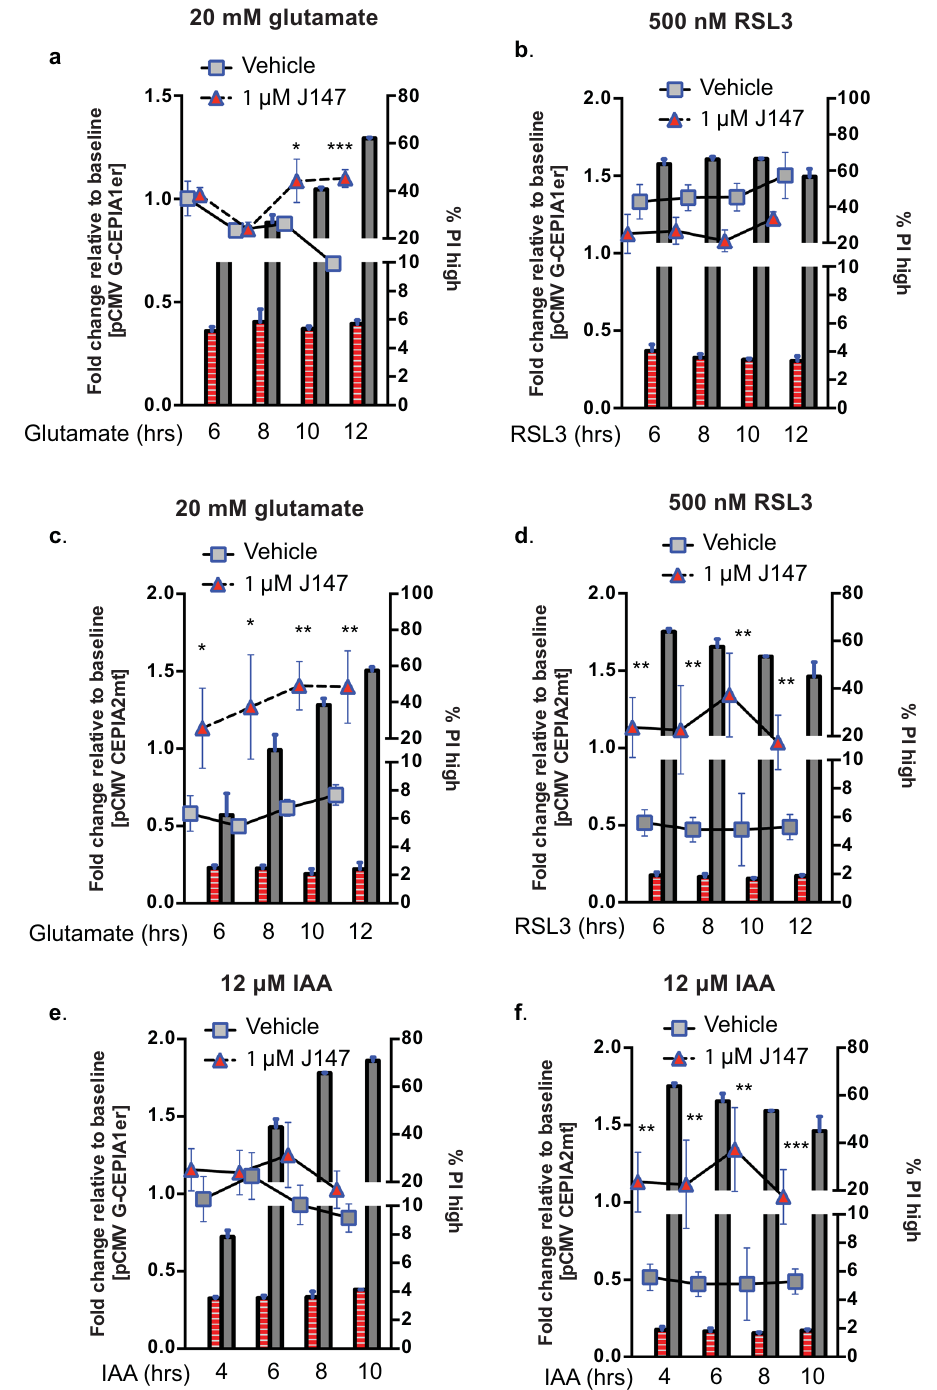
Fig. 5 J147 prevents/normalizes Ca 2 + fl uctuations during glutamate, RSL3, and IAA toxicity. Flow cytometry was used to assess Ca 2 + changes in propidium iodide (PI) positive HT22 cells transfected with genetically encoded Ca 2 + sensors targeted to the ER or mitochondria (red (J147) and gray (vehicle) symbols, dotted lines, left y -axis). Propidium iodide (PI) was used to separate cell populations corresponding to cell viability (red (J147) and gray (vehicle) bars, right y -axis). 1 μ M J147 was used in all conditions. ER ( a , b ) and mitochondria ( c , d ) Ca 2 + levels were measured after the addition of 10 mM glutamate or 500 nM RSL3. ER ( e ) and mitochondria ( f ) Ca 2 + levels were measured after the addition of 12 μ M IAA. Fold changes were normalized to the basal fl uorescence of vehicle untreated cells. Data are plotted as geometric mean fl uorescence intensity fold change, 20,000 – 30,000 cells analyzed per time point. n = 3 exp. for a – f . Multiple t -test (Holm – Sidak method) ,*p < 0.05, **p < 0.01, ***p <